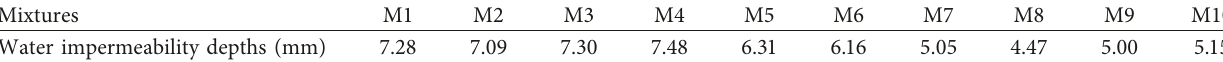
Table 7: Water impermeability depths of SCC series.